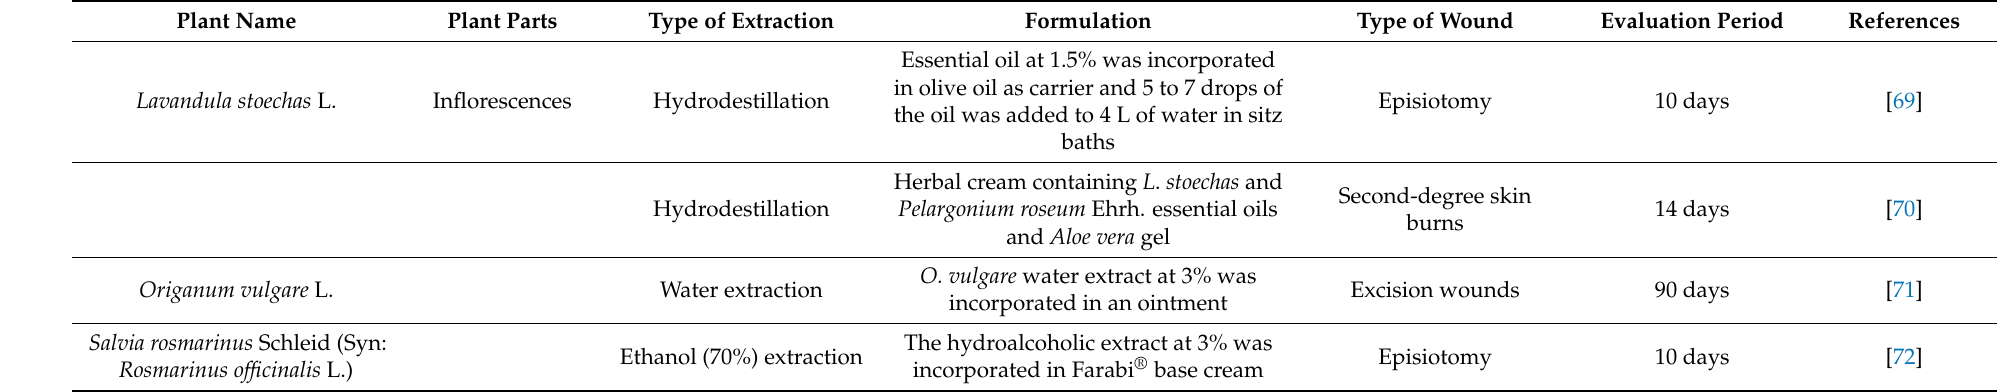
Table 2. Clinical trials using Iberian Lamiaceae species with wound healing activity.